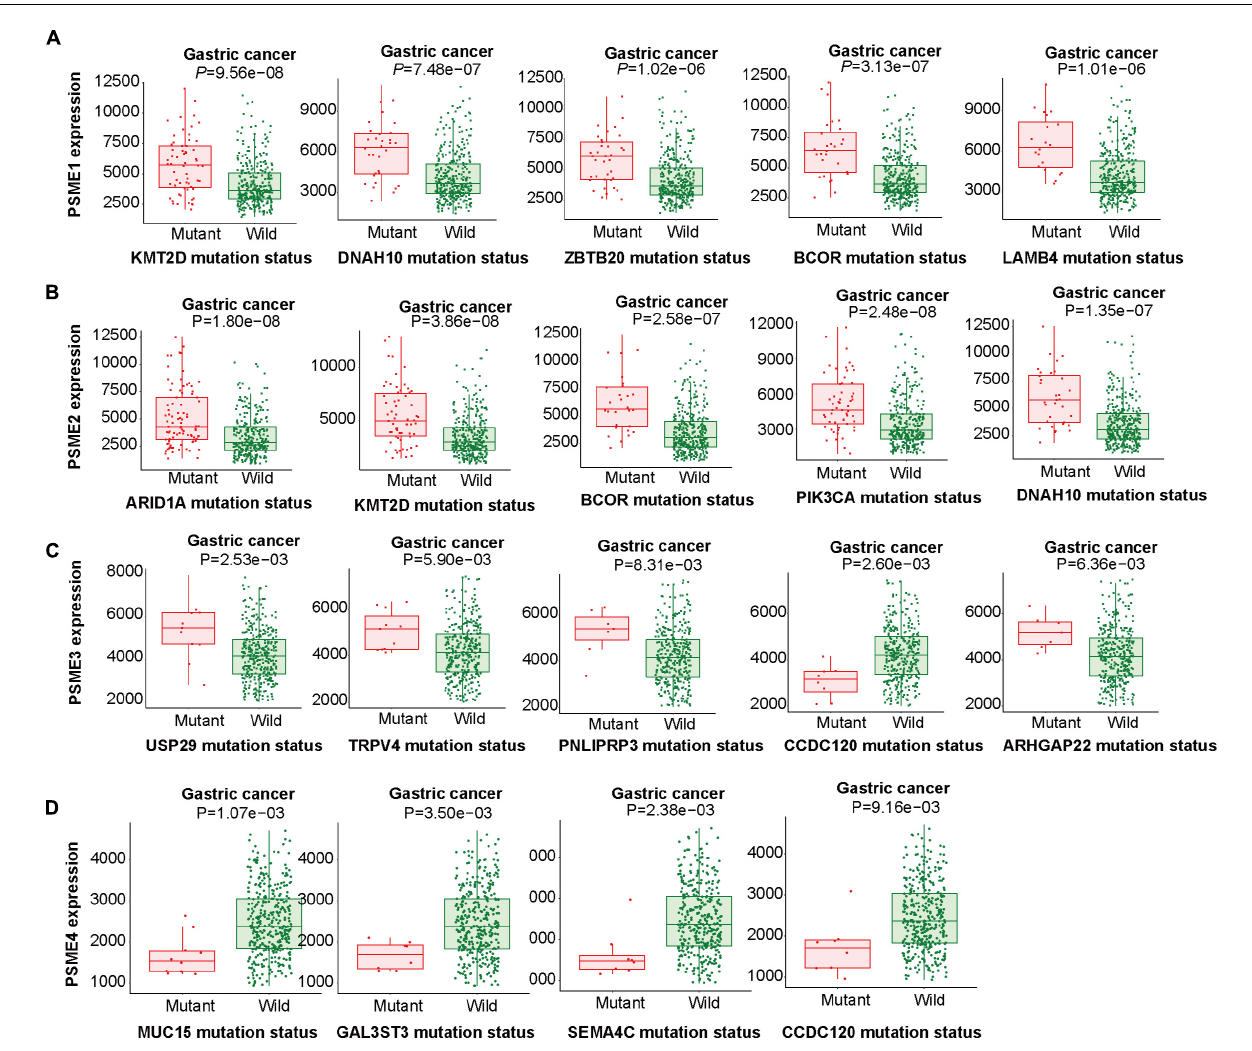
FIGURE 6 | Linking expression changes to mutations. The top five genes whose mutations are most strongly associated with PSME family gene expression changes in GC. (A–D) The top five genes whose mutations are most strongly associated with PSME1, PSME2, PSME3, and PSME4, respectively, expression changes in